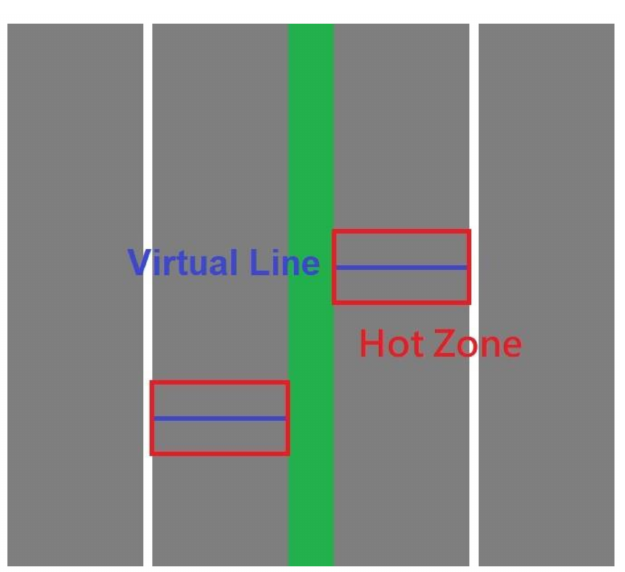
Figure 4. Virtual lines and hot zones of the inner lanes of both directions (conceptualization).